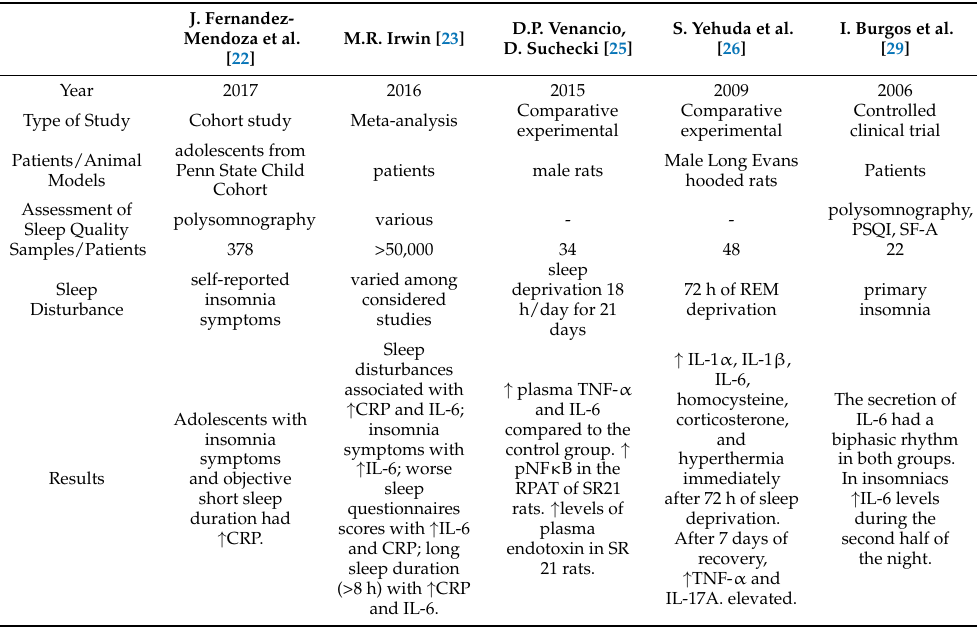
Table 1. Sleep disturbances (with emphasis on insomnia) and alterations of inflammatory markers; a summary of chosen